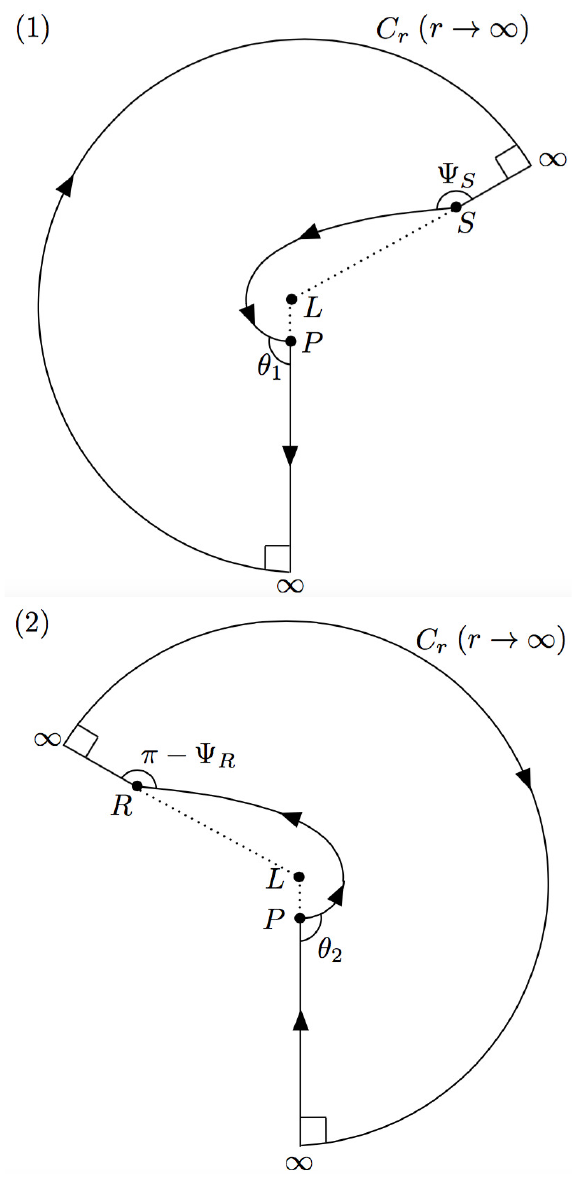
Figure 5. Quadrilaterals: They are made from the photon orbit in a non-Euclidean space. See Figure